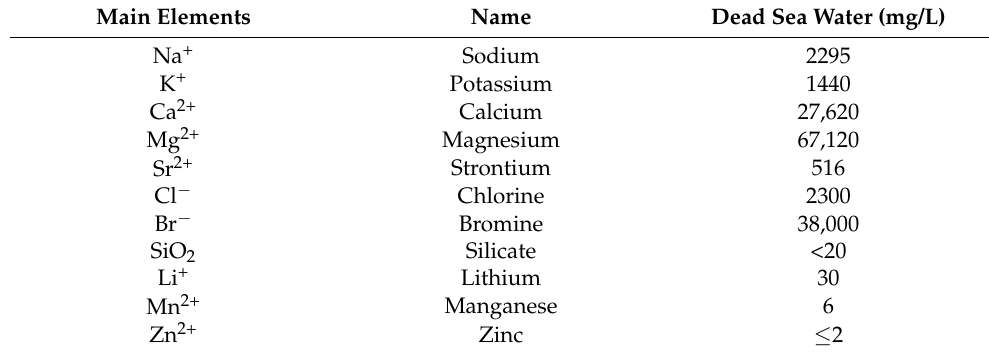
Table 1. Major elements composition in Dead Sea